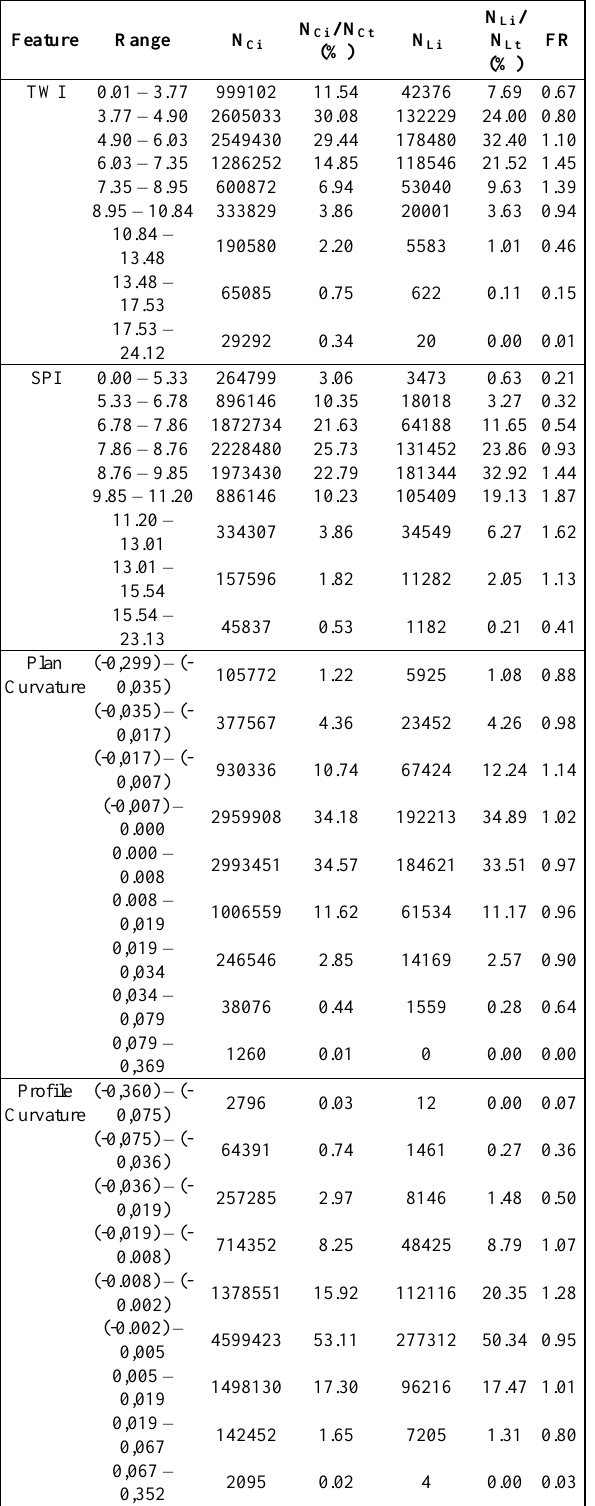
Table A4. FR statistics Elazig part (TWI, SPI, plan and profile